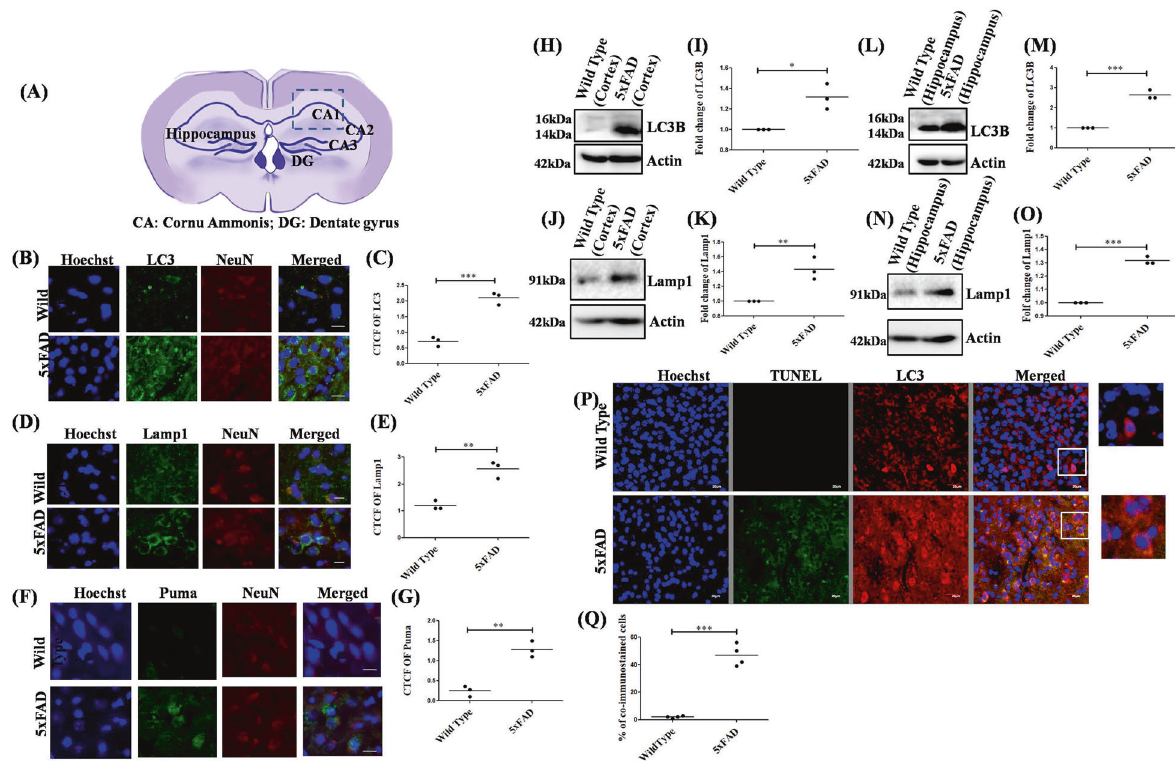
Fig. 6 Apoptosis and autophagy are induced in 5XFAD mice brains. ( A ) Schematic representation of the brain section depicting the Cornu Ammonis 1 (CA1) region from where the microscopic images were collected. Brain sections (20 micron) from the CA1 region of 6 months old 5xFAD mice and wild type mice were taken and stained with Hoechst (blue) for nuclei, neuronal marker NeuN (red) and ( B ) anti-LC3B antibody (green) ( D ) anti-Lamp1 antibody (green) ( F ) anti-Puma antibody (green) respectively. Scale bars: 38 µm. ( C ), ( E ), and ( G ) Graphical representation of the corrected total cell fl uorescence of LC3B, Lamp1, and Puma, respectively. n = 3 mice per group. Data represented were collected from 3 independent experiments. ( H ) and ( J ) represent western blot analysis of change in protein levels of LC3B and Lamp1 wild-type mice. n = 3 mice per group. Data represented were collected from 3 independent experiments. ( L ) and ( N ) represent western blot analysis of change in protein levels of LC3B and Lamp1, respectively of tissue lysates from the hippocampal region of 5xFAD mice brains